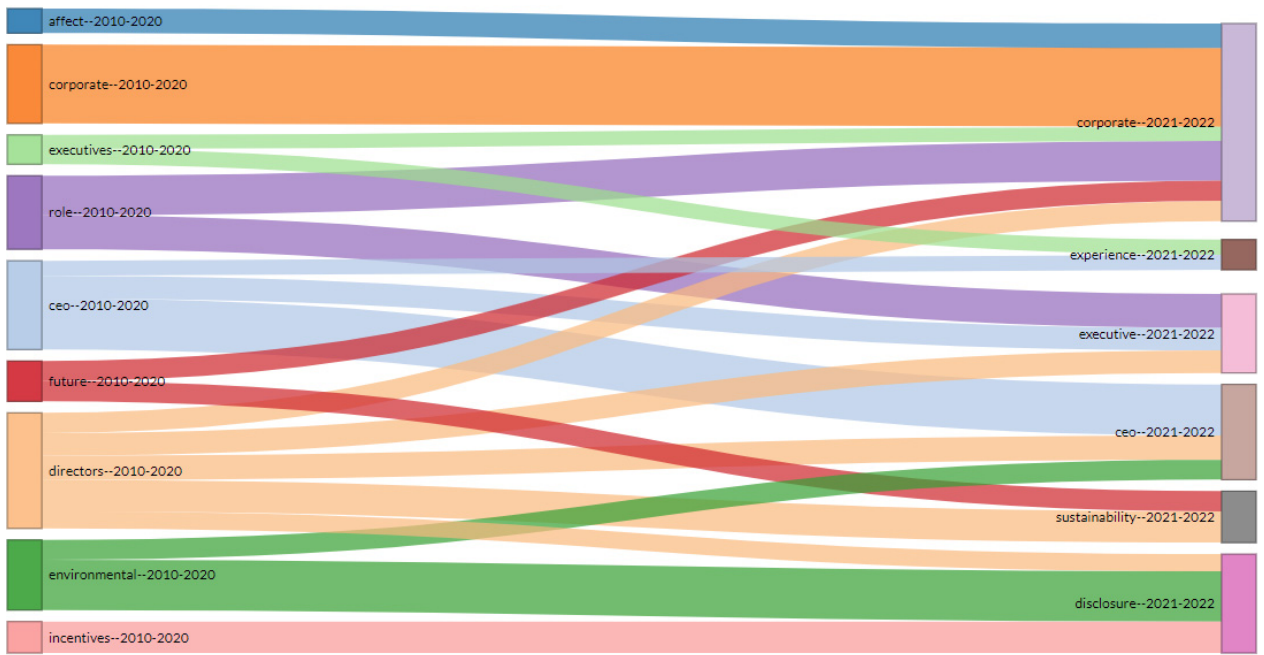
Figure 9. Thematic